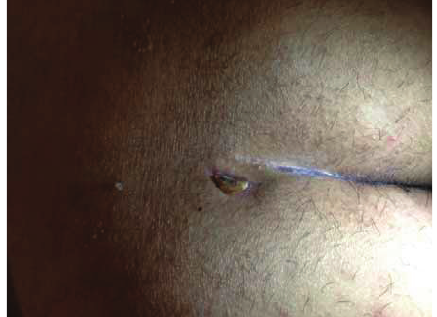
Figure 4: Three weeks after the operation, the reepithelialization was